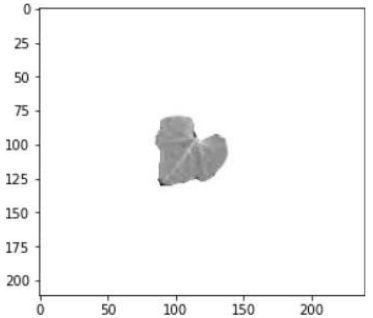
Fig 10. Treatment suggestion for the disease detected.